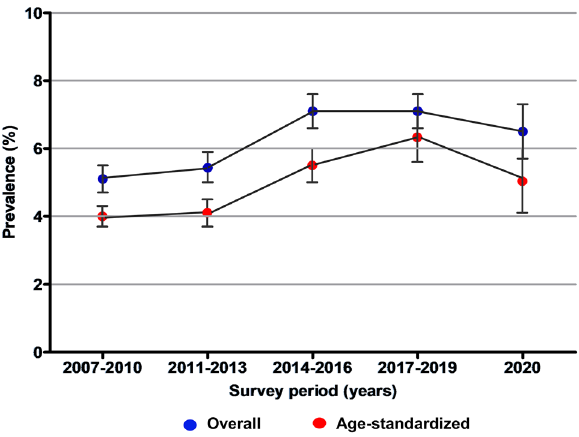
Figure 1. Nationwide 14-year trends and prevalence of CKD among Korean adults, 2007–2020 (n =